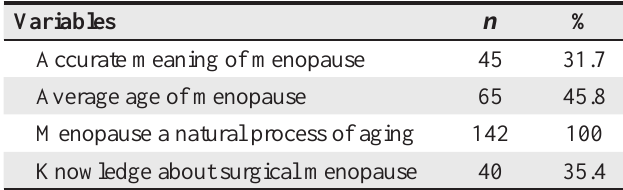
Table 2 : Respondents’ knowledge on menopause (N=142)